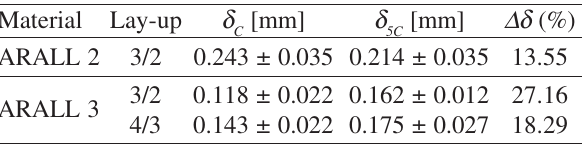
curve of ARALL 3 3/2 (test specimen A). 5